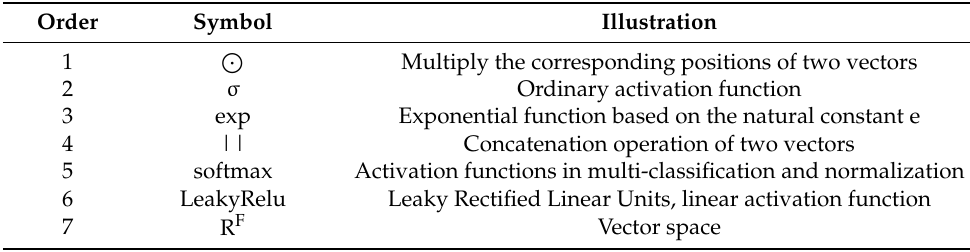
Table A1. Interpretation of special mathematical symbols in the